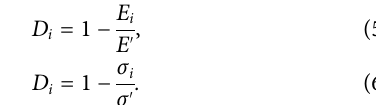
Frontiers in Materials |